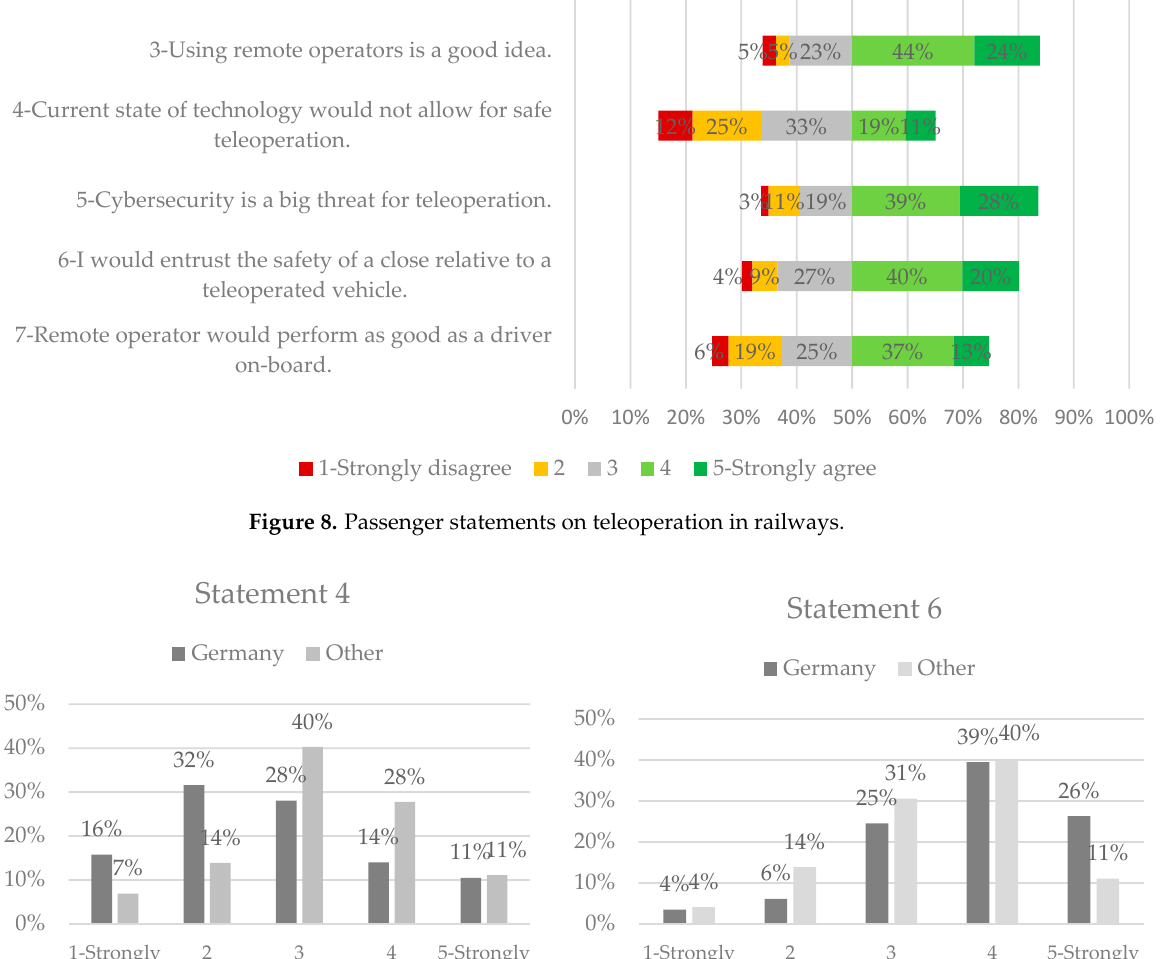
Table 2. Aggregated utilities of CBC attribute levels.